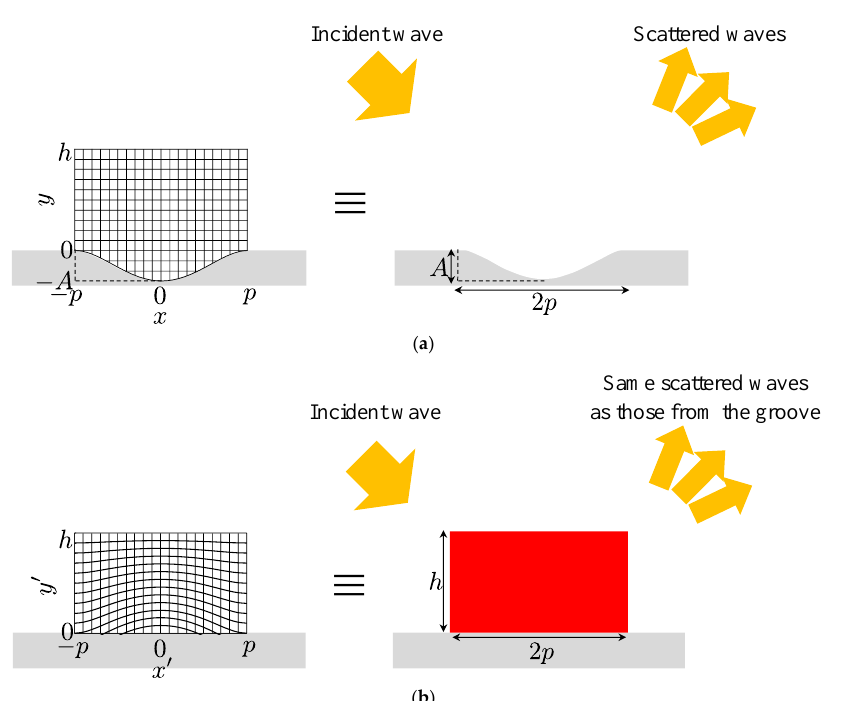
Figure 7. Concept of an illusion medium. ( a ) Original coordinate system on a groove and scatterings of the incident acoustic wave by the groove; ( b ) transformed coordinate system on a flat surface and scatterings of the incident acoustic wave from an illusion medium on the flat surface. The same scattered waves as that from the groove are generated by controlling the trajectory of the incident acoustic wave with the illusion medium and it looks like as if there is the groove on the flat surface.